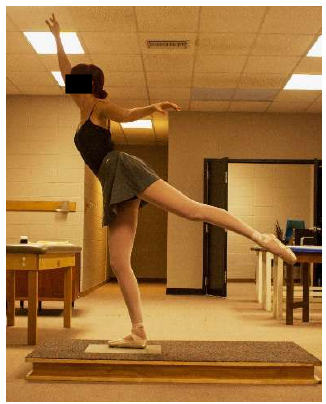
Figure 7. Jump landing in plié on the force plate for sauté arabesque.